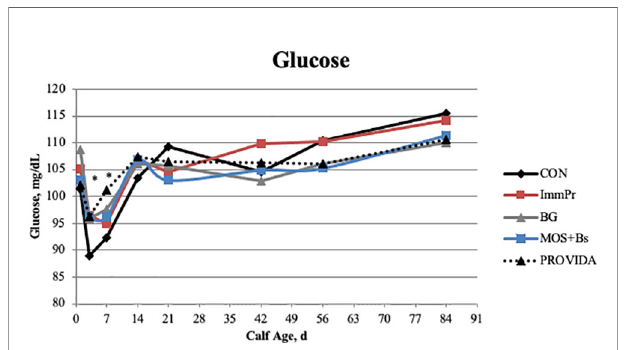
FIGURE 2 | Serum urea nitrogen concentrations were measured on d 0, 3, 7, 14, 21, 42, 56, and 84. There was a treatment x time interaction ( P ≤ 0.023). The ImmPr had a lower plasma urea nitrogen concentration on d 14 than CON, PROVIDA, and MOS+Bs ( P ≤ 0.041). However, MOS+Bs had an elevated plasma urea nitrogen concentration on d 84 than CON, ImmPr, and PROVIDA ( P ≤ 0.004). Lastly, plasma urea nitrogen concentration was greater on d 84 for BG when compared to ImmPr ( P = 0.006). Largest SEM per time point are expressed as mg/dL and include 1.128, 1.334, 1.241, 0.997, 0.858, 0.855, 0.789, and 0.881 for d 1, 3, 7, 14, 21, 42, 56, and 84, respectively. An * indicates a treatment difference of ( P ≤ 0.05) when treatments were sliced by